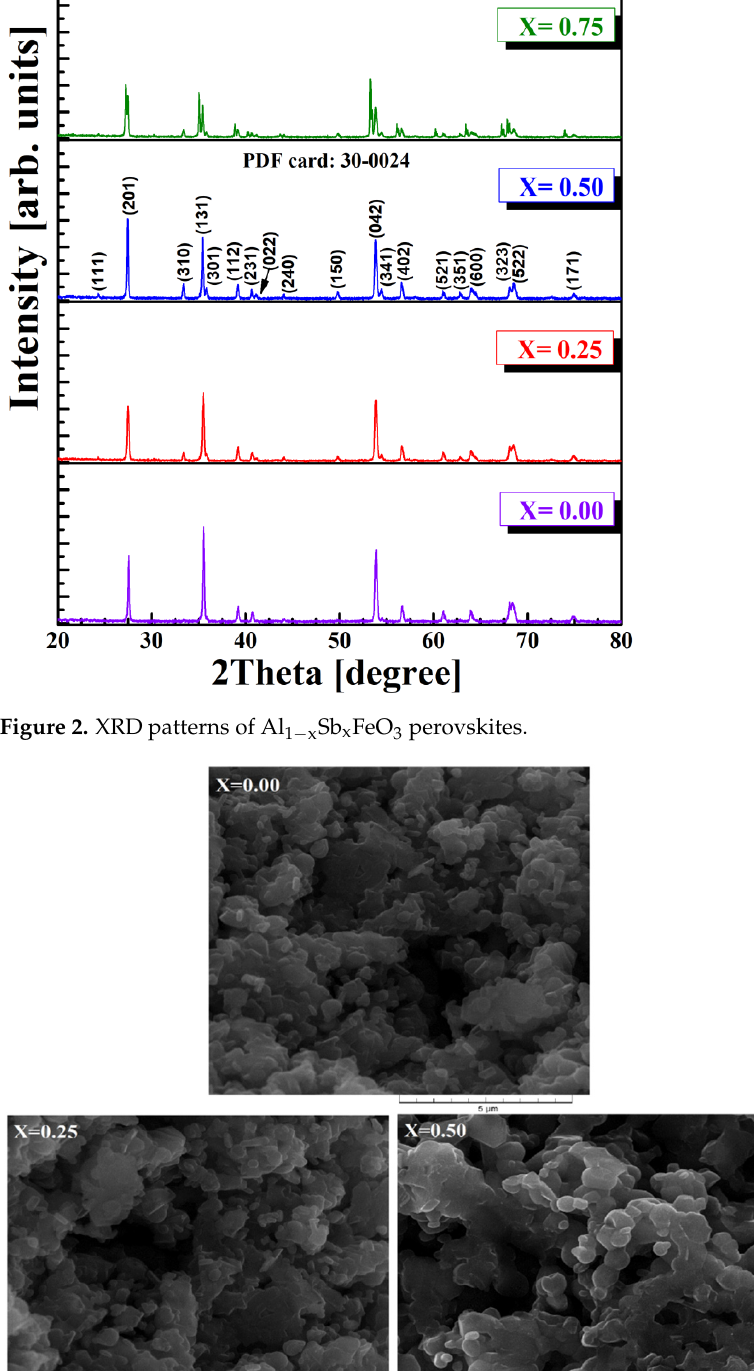
Figure 3. SEM micrographs of Al 1-x Sb x FeO 3 perovskites. From the micrographs shown in Figure 3, it is obvious that the sample for x=0 shows a fine hexagonal micronic structure, constituted of small crystallites, and sample for x=1 shows large conglomerates of crystallites placed side by side together. This structure shape indicates that the sample x=1 can easily permit absorption and condensation of water vapor inside. Similar results are reported in the literature by [28,29]. The 3D topographic profile of the surface of the multiferroic perovskite sample Al 0.5 Sb 0.5 FeO 3 was made using an optical profilometer model ZygoZeGage with non-contact cantilever in normal temperature and pressure conditions. Figure 4 shows the representative parameters of the sample surface area, calculated by profilometer software: R a —represents the arithmetic area; S a —represents the mathematical area of the pixels; S q —represents the square area of the pixels and S z —represents the topographic difference between the highest and lowest points. From analysis of the surface topogra- phy of the perovskite sample shown in Figure 4, we notice that the surface is not rough and in some places presents agglomerations of crystallites, which is agreement with the SEM micrographs shown in Figure 3.